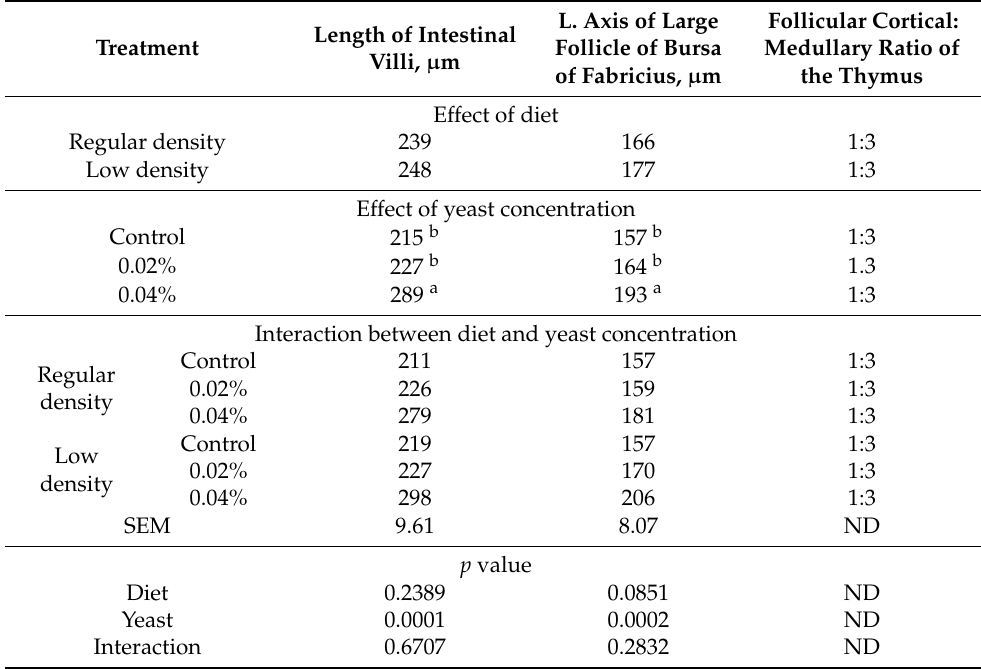
Table 9. Impact of different concentrations of Saccharomyces cerevisiae on the morphology of the intestine, bursa of Fabricius and follicular cortical:medullary ratio of the thymus in 38-day-old broilers fed regular- or low-density diet. Follicular Cortical: L. Axis of Large Length of Intestinal Medullary Ratio of Follicle of Bursa Treatment Villi, µ m the Thymus of Fabricius, µ m Effect of diet